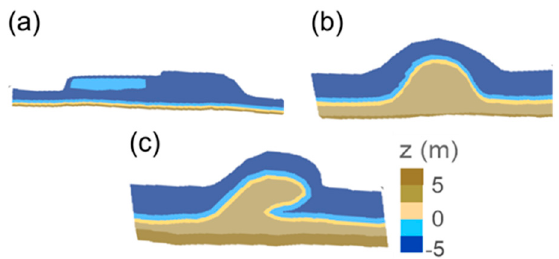
Figure 1. Three types of Sand Engine design (after [15]: ( a ) beach face nourishment; ( b ) bell ‐ shaped nourishment; ( c ) hook ‐ shaped nourishment.